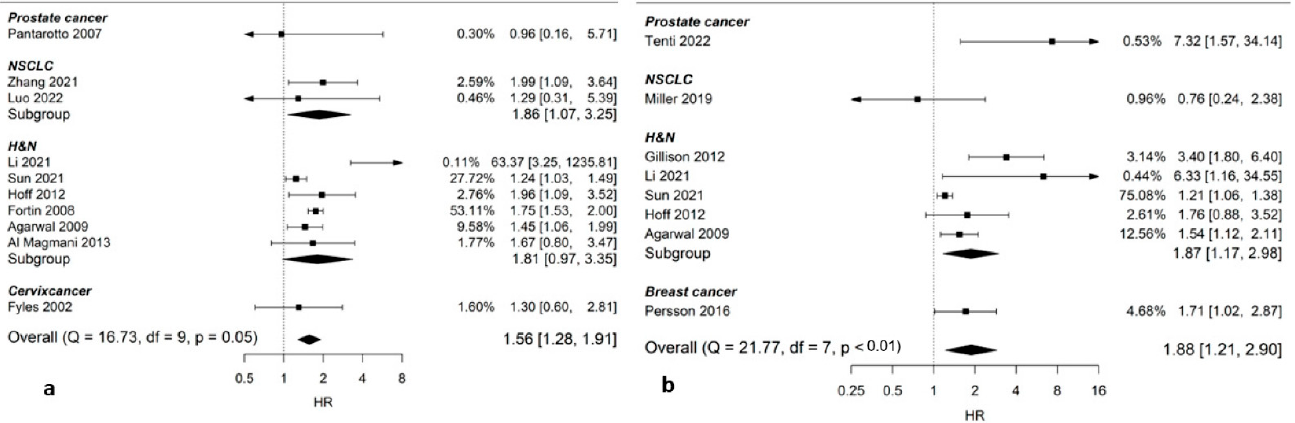
Figure 2. Forest plots on pooled Hazard Ratios (HRs) on smoking during radiotherapy and efficacy. ( a ) Smoking during radiotherapy and locoregional recurrence free survival; ( b ) smoking during ra- diotherapy and disease-free survival. HR > 1 indicates worse outcome for smokers during radiation treatment, whereas HR < 1 indicates better outcome. Comparison group is non-smoker (former or never). Abbreviations : NSCLC, non-small-cell lung cancer; H&N, head and neck cancer.